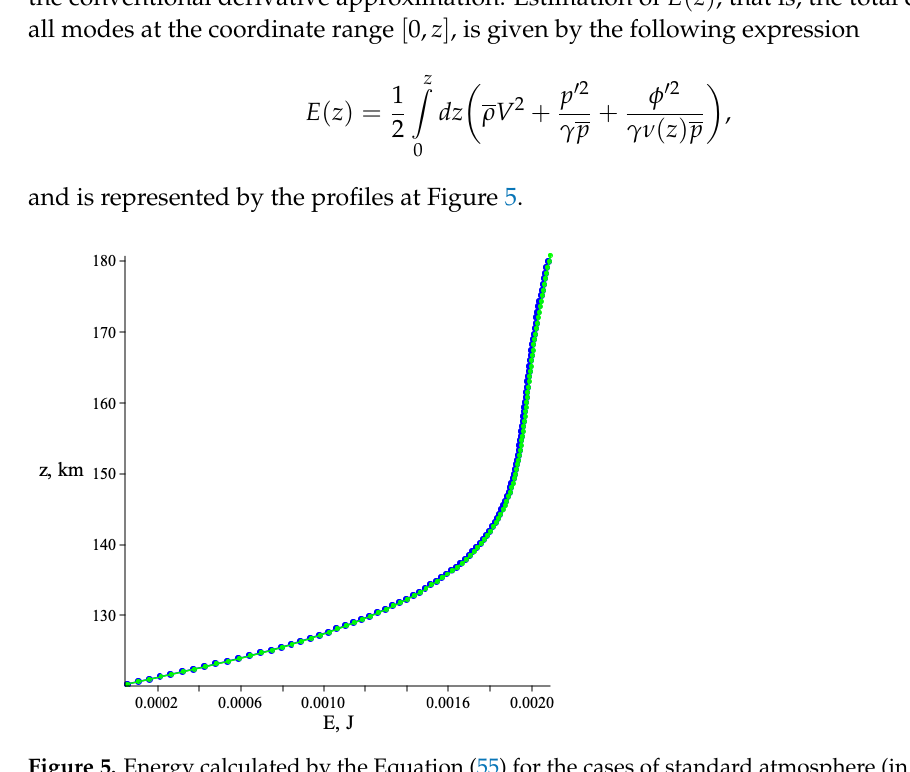
Figure 5. Energy calculated by the Equation (55) for the cases of standard atmosphere (in blue) and linear dependence (in green) of the height scale H ( z ) for z ∈ [ 120,180 ] km, see the relation